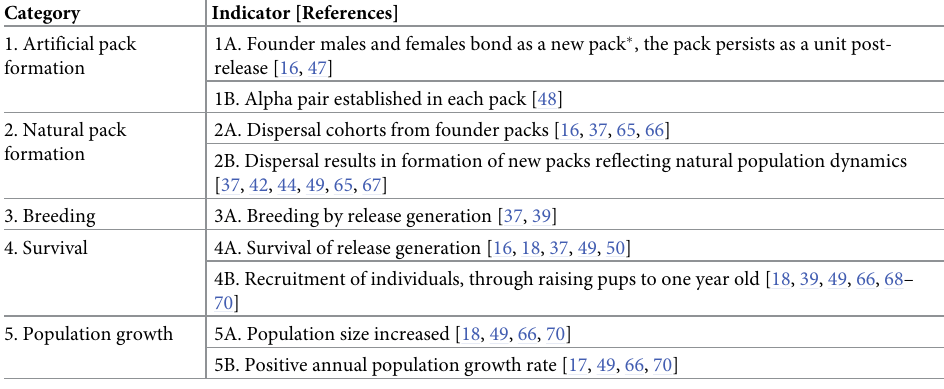
Table 1. Framework for evaluating short-term success of the wild dog reintroduction to Gorongosa National Park,